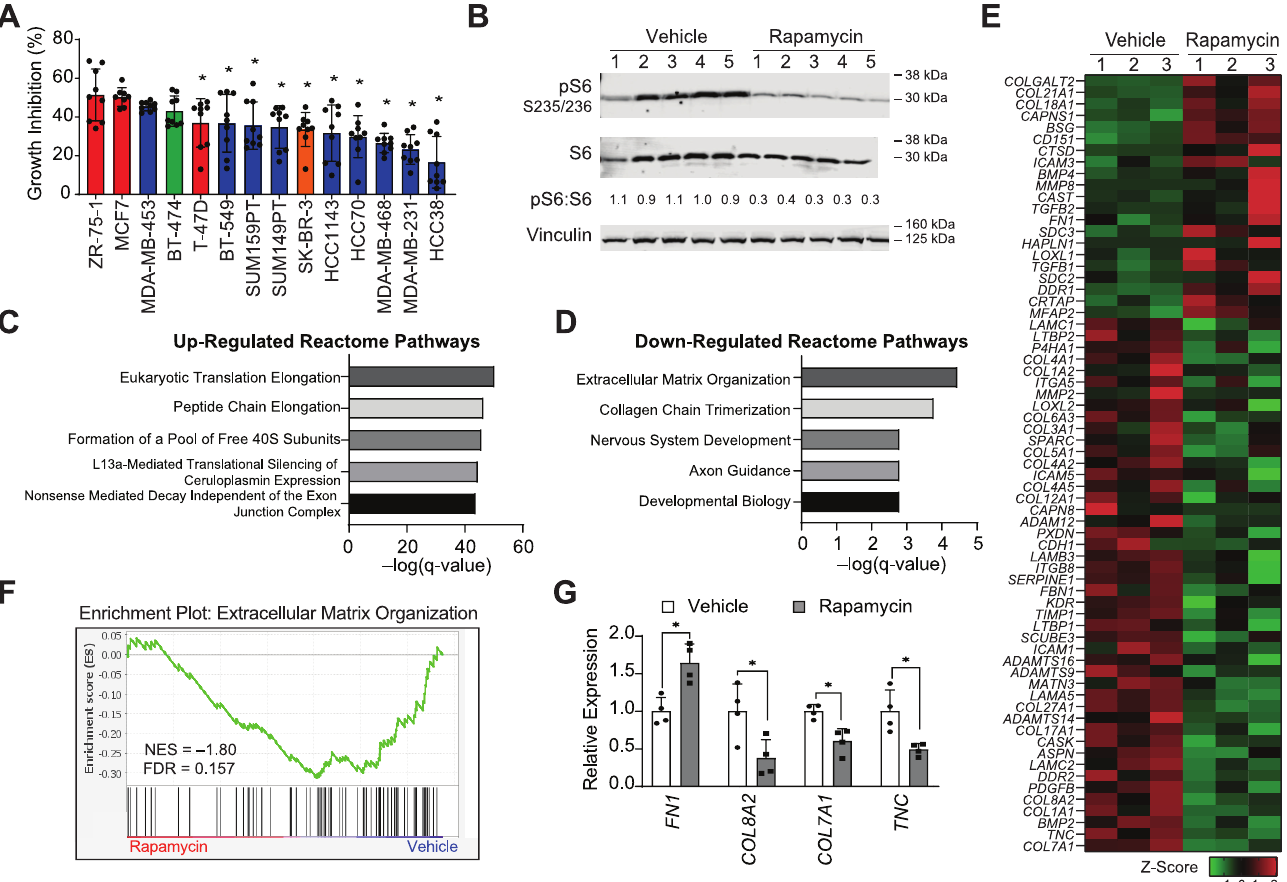
Figure 1. Inhibition of mTORC1 signaling in resistant tumors reveals an association with the extracel- lular matrix. ( A ) Relative growth inhibition of breast cancer cell lines in response to 1 µ M rapamycin after 3 days of treatment. Each cell line was compared to their vehicle (DMSO) control (set to 1, not shown). Data is expressed as average ± STDEV (* = p < 0.05 compared to ZR-75-1 cells); n = 3 independent experiments in triplicate. Different colors represent different receptor-defined subtypes: red, ER+/PR+/HER2-, green, ER+/PR+/HER2+, orange, ER-/PR-/HER2+, blue, ER-/PR-/HER2-. ( B ) Representative western blots examining levels of phosphorylated S6 (pS6 S235/236), total S6 (S6), and vinculin (loading control); the quantitation of the pS6 to S6 ratio is shown. Total protein loading is shown in Supplementary Figure S1A. Numbers indicate different tumors. Reactome pathway enrichment analysis of the ( C ) differentially up- and ( D ) down-regulated genes in MDA-MB-231 xenografted tumors following 3 days of rapamycin treatment. ( E ) Heatmap and ( F ) GSEA plot of differentially expressed genes (FDR < 0.5) in the reactome pathway: extracellular matrix organization. ( G ) Confirmation of gene expression changes for FN1 , COL8A2 , COL7A1 , and TNC in MDA-MB-231 orthotopic xenografts in response to rapamycin. Data are expressed as average ± SD (* = p < 0.05 compared to respective vehicle); n = 4 independent